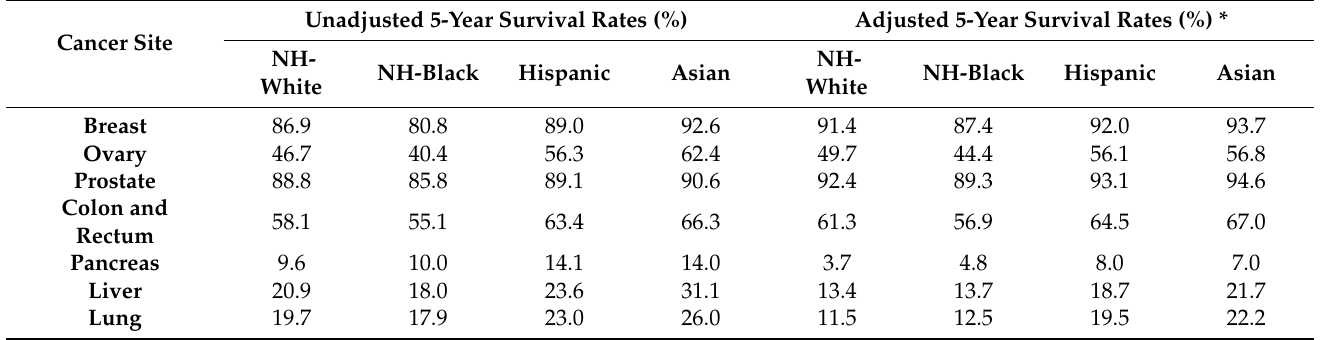
Table 1. Five-year survival rates of major cancer types according to